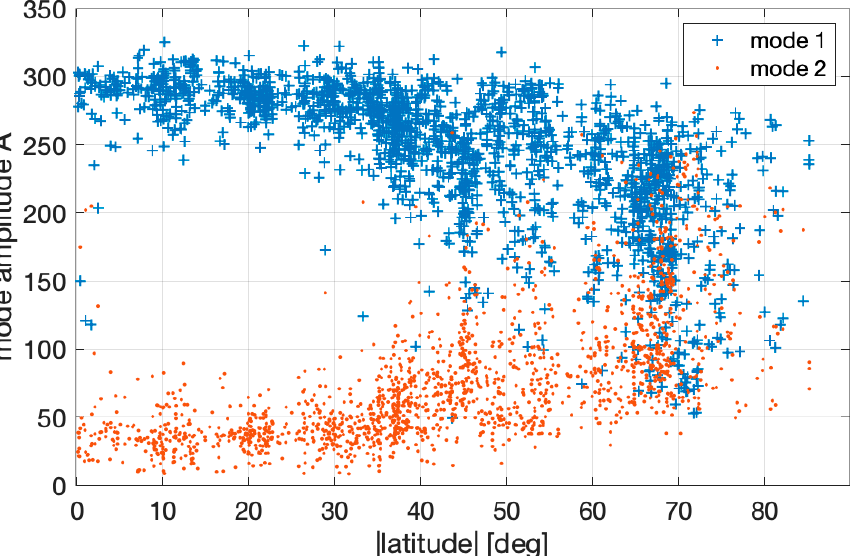
Figure 3. Latitudinal dependence of the amplitude A of modes 1 and 2. The latitude is the median latitude during the profile.